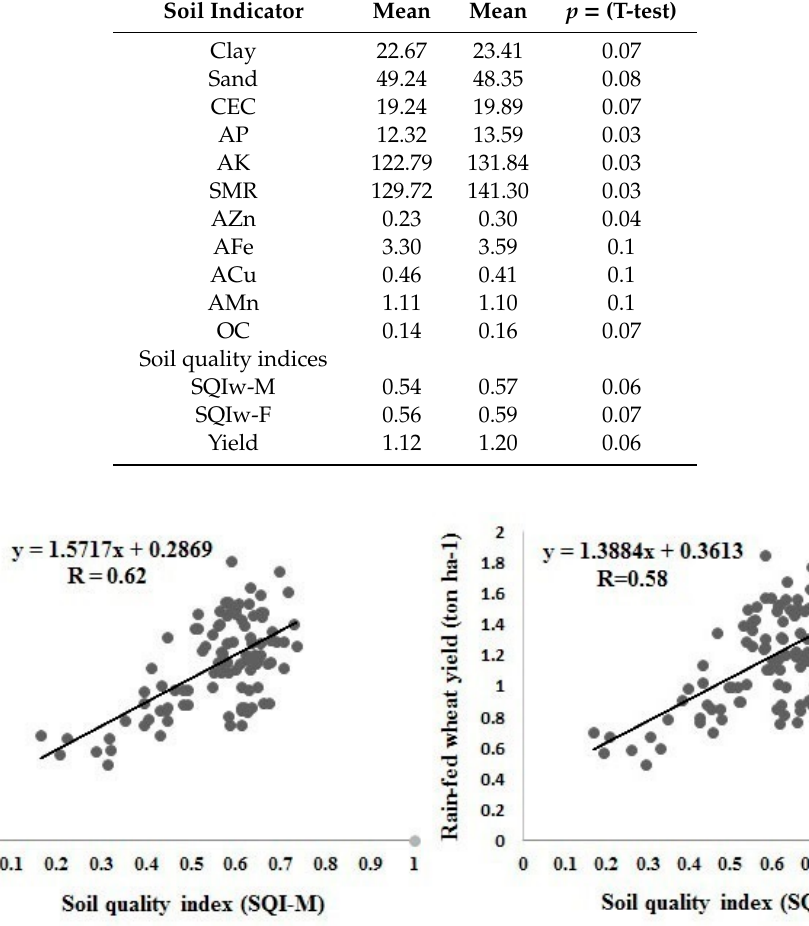
Figure 4. Linear relationship between SQIs calculated using two weighting methods (SQIw-M and SQIw-F) and rainfed wheat yield for all soil samples.